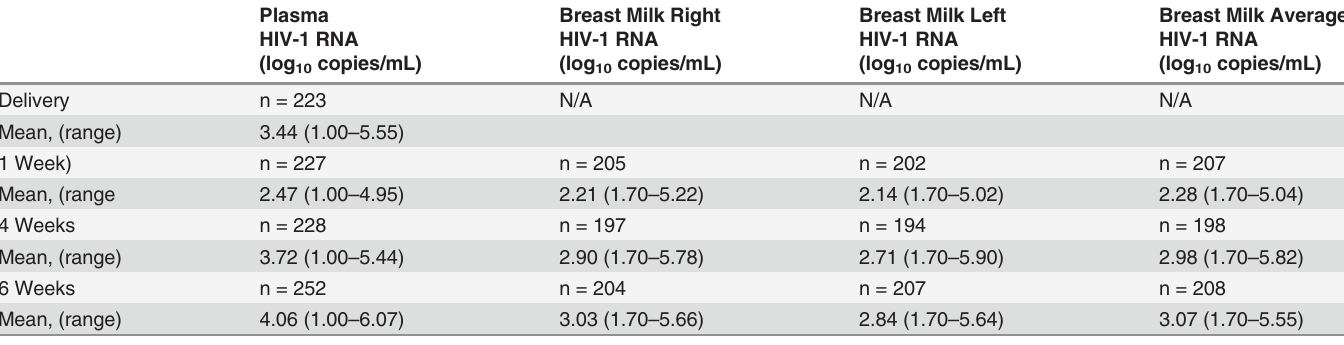
Table 2. Plasma and Breast Milk HIV-1 RNA through 6 Weeks after Short-Course Antiretroviral Prophylaxis in 273 HIV-Infected Women. Plasma Breast Milk Right Breast Milk Left Breast Milk Average HIV-1 RNA HIV-1 RNA HIV-1 RNA HIV-1 RNA (log 10 copies/mL) (log 10 copies/mL) (log 10 copies/mL) (log 10